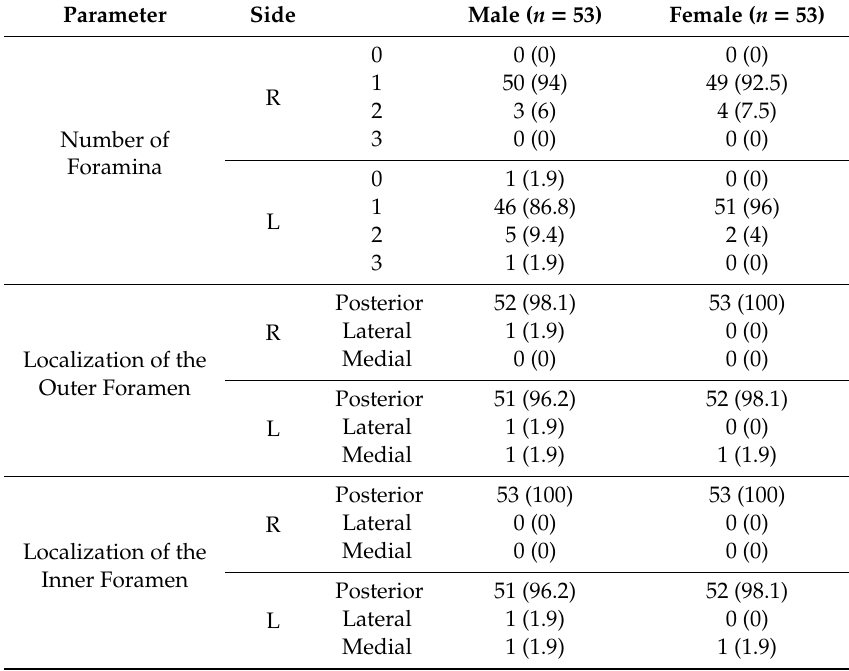
R = right side; L = left side; values are given as absolute numbers and (percentages).